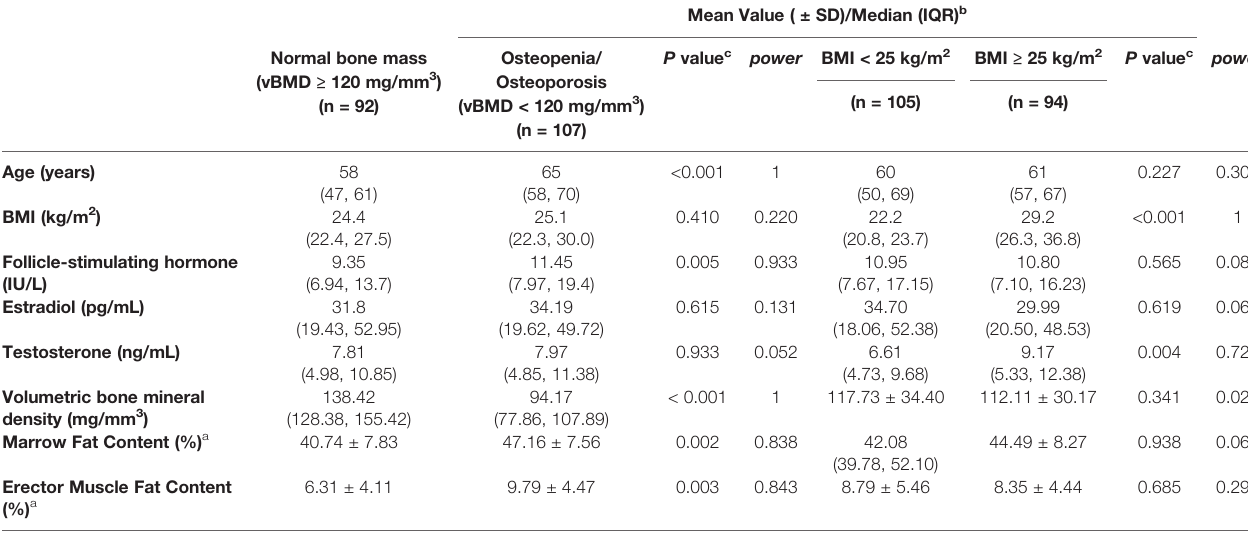
TABLE 2 | Comparisons of demographic and biologic characteristics between the participants with normal bone mineral content and with decreased bone mineral content (osteopenia or osteoporosis), and between non-obese and obese